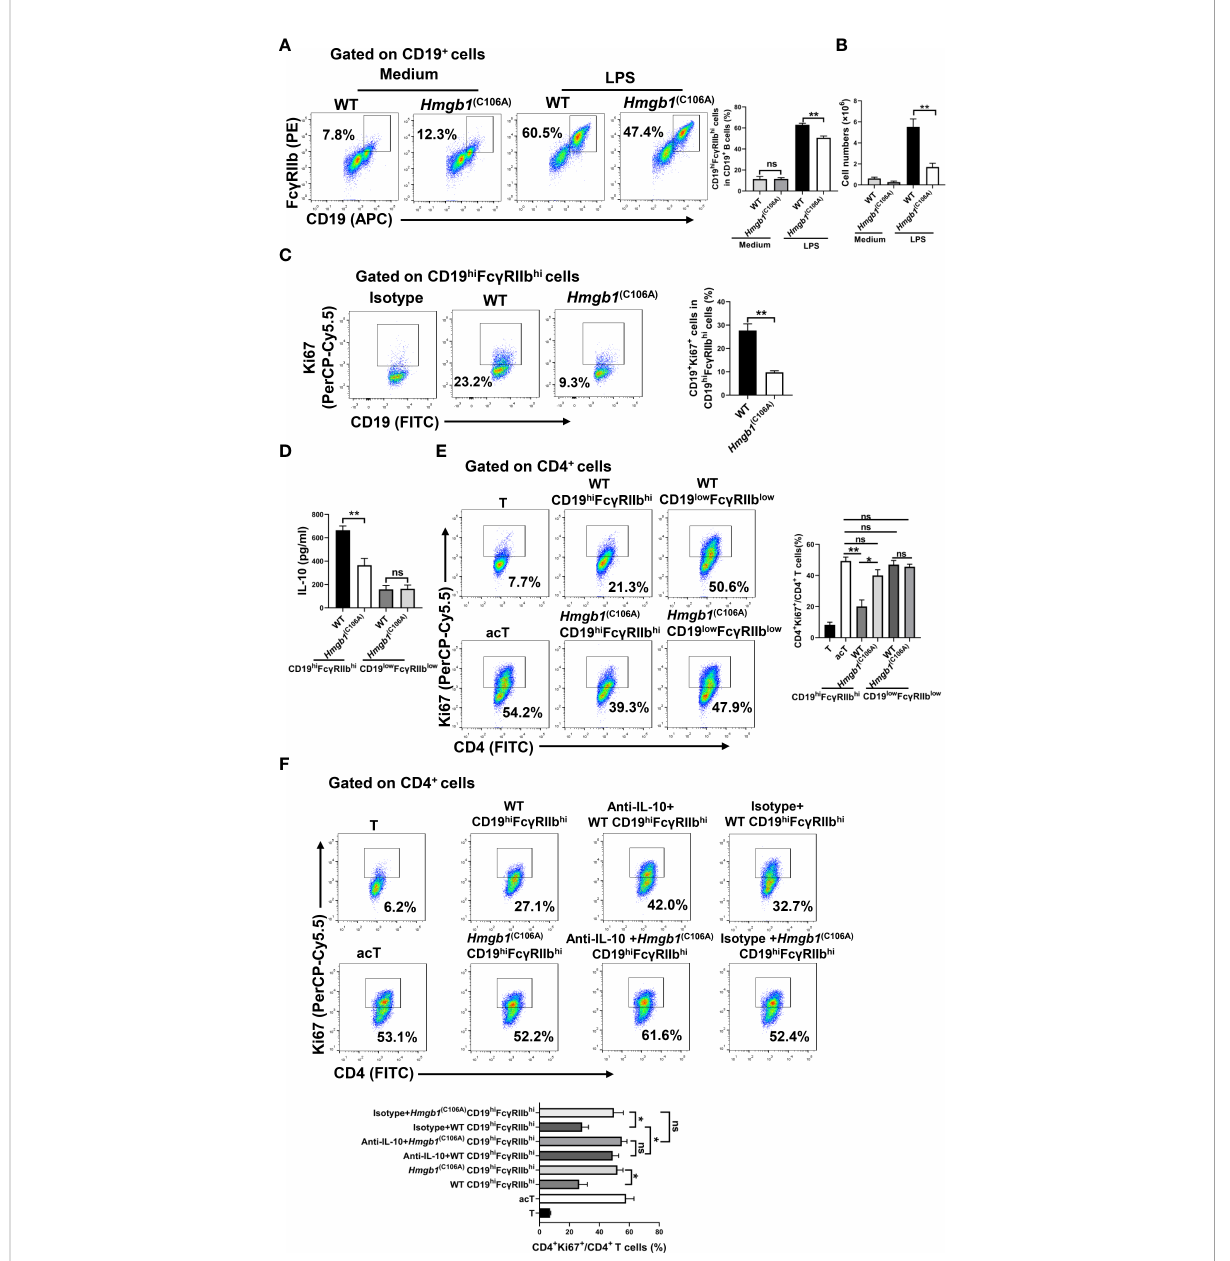
FIGURE 3 Decreased expansion and suppressive function of CD19 hi Fc g RIIb hi B cells among Hmgb1 (C106A) B cells. (A, B) Splenic CD19 + B cells from Hmgb1 (C106A) or WT mice were treated with or without LPS for 2 days. Flow cytometry was performed to assess the percentage (A) and number (B) of CD19 hi Fc g RIIb hi B cells. Data are shown as means ± SEMs of three independent experiments. (C) Highly puri fi ed splenic CD19 + B cells from Hmgb1 (C106A) or WT mice were cocultured with LPS for 48 h in vitro , and the percentage of proliferating (Ki67 + ) CD19 hi Fc g RIIb hi B cells among WT and Hmgb1 (C106A) B cells was analyzed by fl ow cytometry with Ki67 staining. Data are shown as means ± SEMs of three independent experiments. (D) Splenic CD19 + B cells from Hmgb1 (C106A) or WT mice were treated with LPS for 2 days; CD19 hi Fc g RIIb hi B cells and CD19 low Fc g RIIb low B cells were sorted from WT and Hmgb1 (C106A) B cells by fl ow cytometry. CD19 hi Fc g RIIb hi B cells and CD19 low Fc g RIIb low B cells (2 × 10 5 ) sorted from Hmgb1 (C106A) or WT B cells were plated in 96-well plates. After 24 h, supernatants were collected for measurement of IL-10 levels by ELISA. Data are shown as means ± SEMs of three independent experiments. (E, F) Splenic CD19 + B cells from Hmgb1 (C106A) or WT mice were treated with LPS for 2 days; CD19 hi Fc g RIIb hi B cells and CD19 low Fc g RIIb low B cells were sorted from WT and Hmgb1 (C106A) B cells by fl ow cytometry. CD19 hi Fc g RIIb hi B cells (2 × 10 5 ) sorted from Hmgb1 (C106A) or WT B cells were cocultured with anti-CD3/CD28-activated CD4 + T cells (2 × 10 5 ) (E) in the presence or absence of anti-IL-10 (F) . After 3 days, CD4 + T cell proliferation was analyzed by fl ow cytometry. Data are shown as means ± SEMs of three independent experiments. *P < 0.05; **P < 0.01; NS, not signi fi